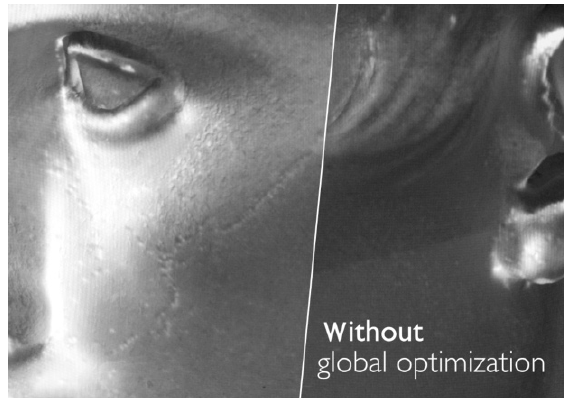
Fig. 7 Results of our global optimization step.